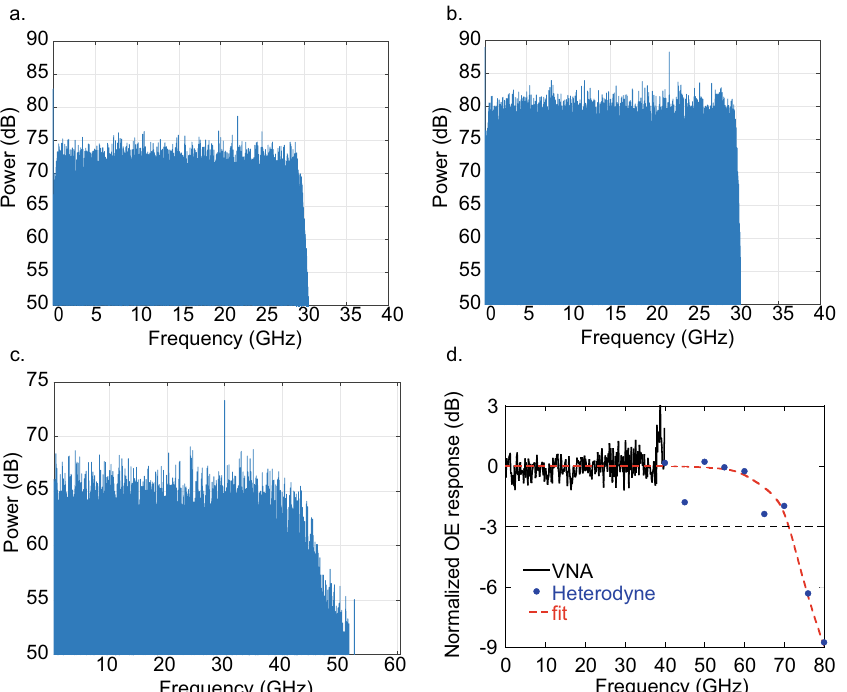
Fig. 7 Frequency response. Electrical spectra of the received signals: 60 GBaud NRZ OOK ( a ), 60 GBaud PAM4 ( b ), and 105 GBaud NRZ OOK ( c ). d Optical to electrical bandwidth of the received signal: black curve is the measurement as acquired from the VNA, blue dots are the measured response as obtained by the heterodyne setup with laser beating, the red dashed line is the interpolation